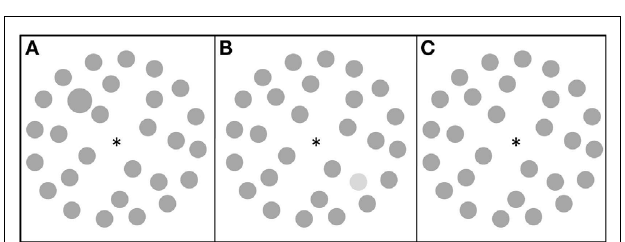
FIGURE 1 | Movement cues: grasping movement cue (left) and pointing movement cue (right). The cues were made to be as physically similar as possible, so that they would not elicit different brain response related to their physical characteristics.